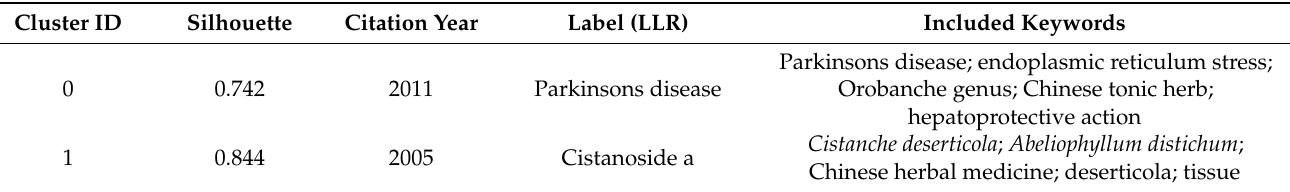
Figure 8. Keyword analysis in Cistanche ‐ related study (1980–2022). ( A ) Node size represents the frequency of keyword occurrences. Purple circles indicate that the keyword is the focus of the study. Red nodes indicate hot spots of study. ( B ) The top 10 keywords with the most frequency. Table 4. Keyword Cluster